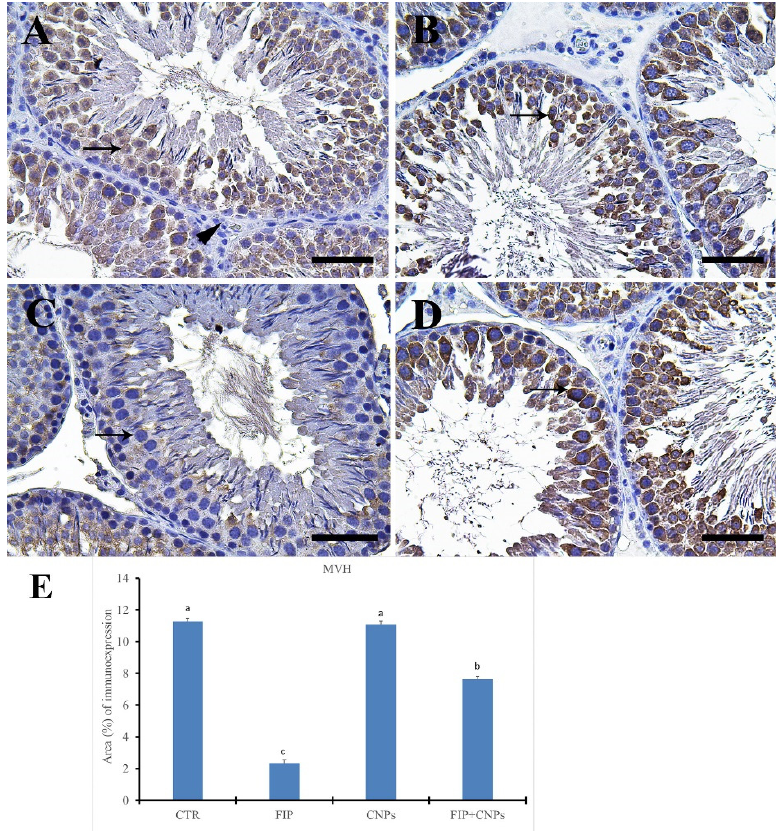
Figure 8. Immunohistochemical staining of rat testis by mouse vasa homologue (MVH). ( A ) Control group showed the strong positive MVH reaction in all spermatogenic cells (arrow) with negative reaction in the interstitial tissue (arrowhead). ( B ) CeNPs group. ( C ) FIP group revealed nearly negative MVH in all spermatogenic cells (arrow). ( D ) FIP treated with CeNPs showing strong positive MVH reaction in all spermatogenic cells (arrow). ( E ) Quantification of MVH in the testicular tissues in different groups. Scale bar = 50 µm . Data expressed as mean ± SE, analyzed using one-way ANOVA at p ≤ 0.05.